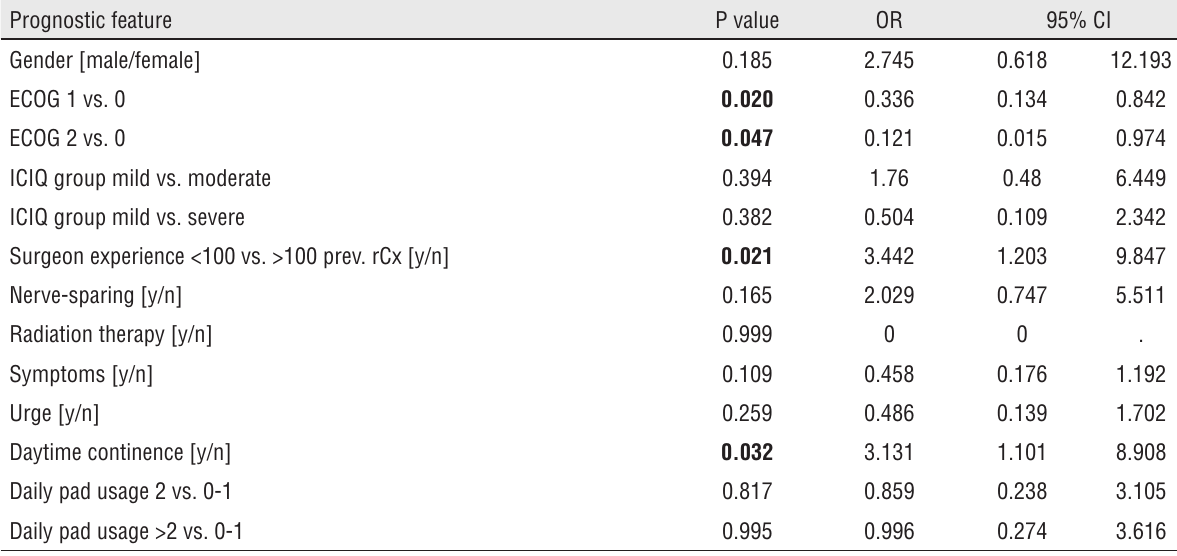
Table 3 - Multivariate analysis of prognostic features that showed significant results in univariate analysis. Prognostic feature P